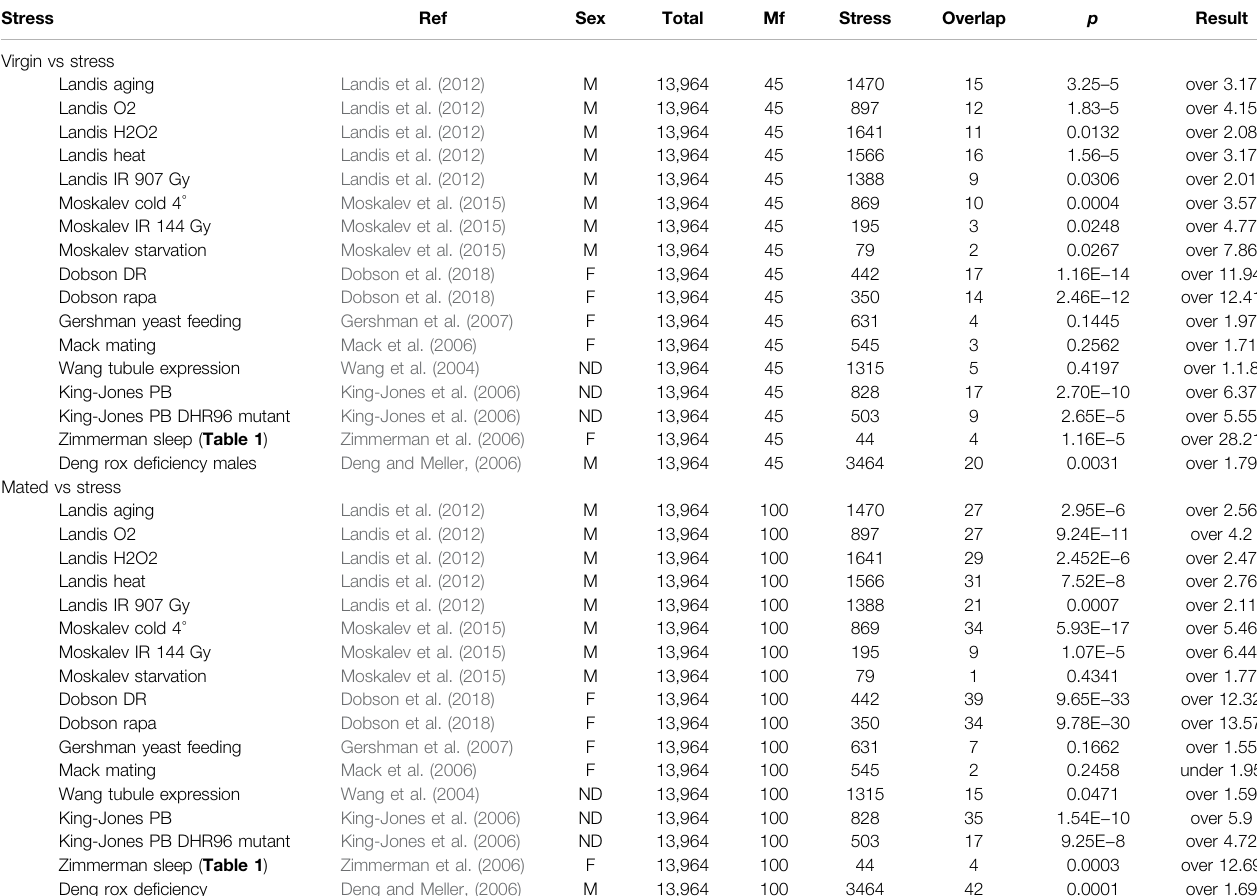
TABLE 1 | Effect of mifepristone in mated and virgin females compared to various stresses.